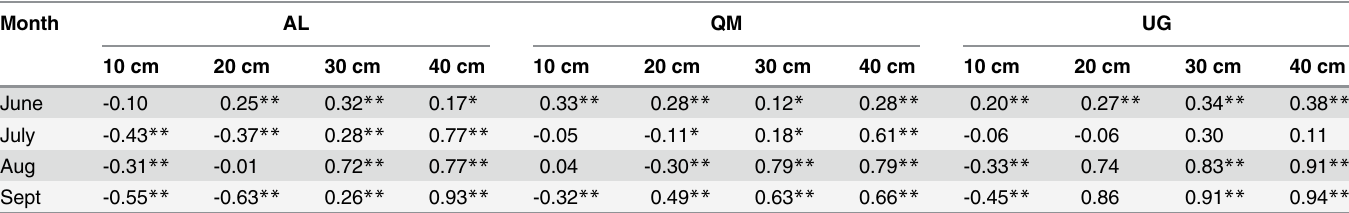
Table 4. Pearson correlations between soil temperature and soil moisture for the three vegetation types. Month